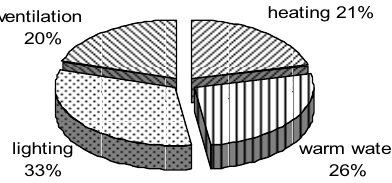
Fig. 9. The energy percentage used for creating thermal comfort and